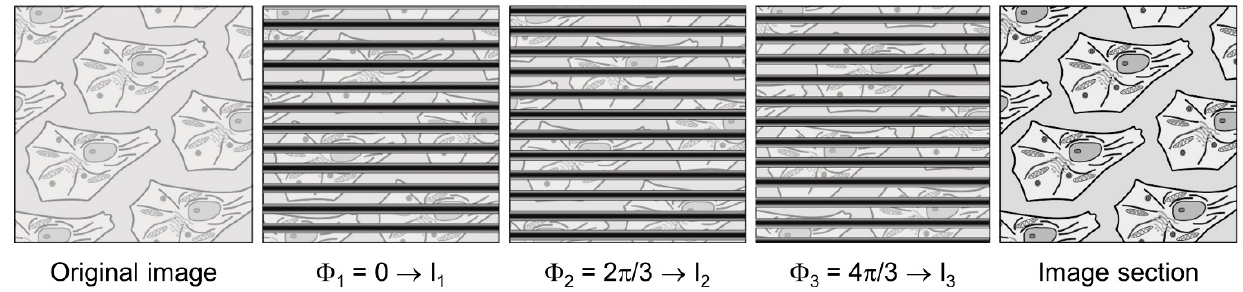
Figure 4. Principle of Optical-Sectioning Structured Illumination Microscopy (OS-SIM). Reproduced from [51] with modifications.